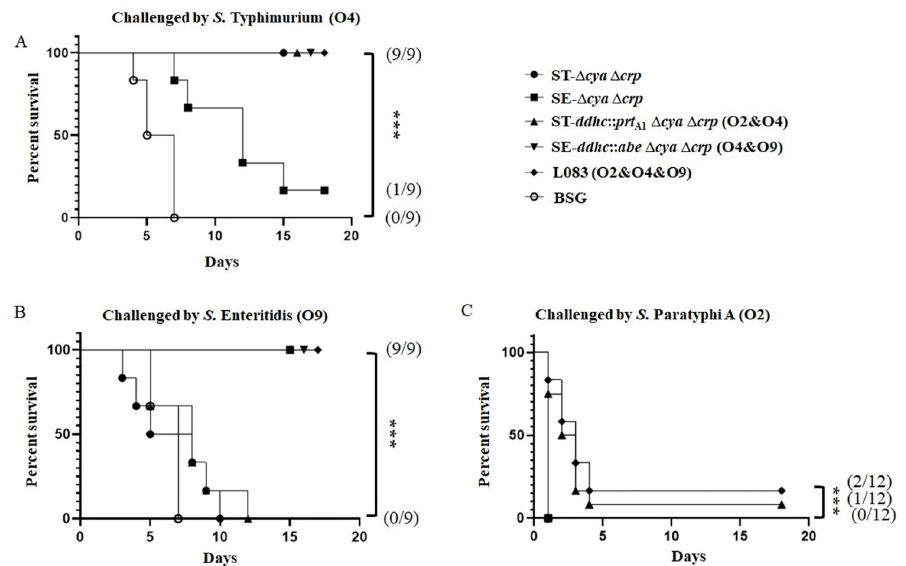
Fig 8. Survival curves after a challenge by wild-type virulent Salmonella . Five weeks after primary immunization, nine to twelve mice from each group were challenged orally or intraperitoneally with approximately 100 times the LD 50 of the wild-type virulent S . Typhimurium (A), S . Enteritidis (B) and S . Paratyphi A (C). Curve comparisons were calculated using GraphPad Prism by comparing two groups by the log-rank (Mantel-Cox) test for all the marked groups versus the PBS group. ��� , P < 0.001. The numbers in brackets represented the number of mice alive at the end of the experiment/number of mice challenged.